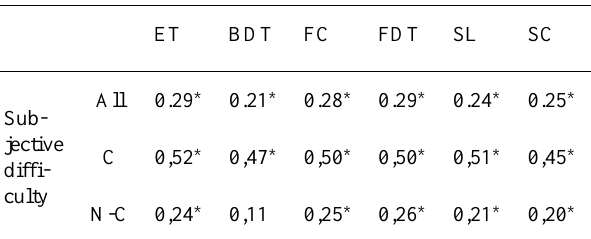
The Pearson’s correlation coefficient for the selected eye- tracking parameters and the evaluation of the task difficulty level and the results obtained.